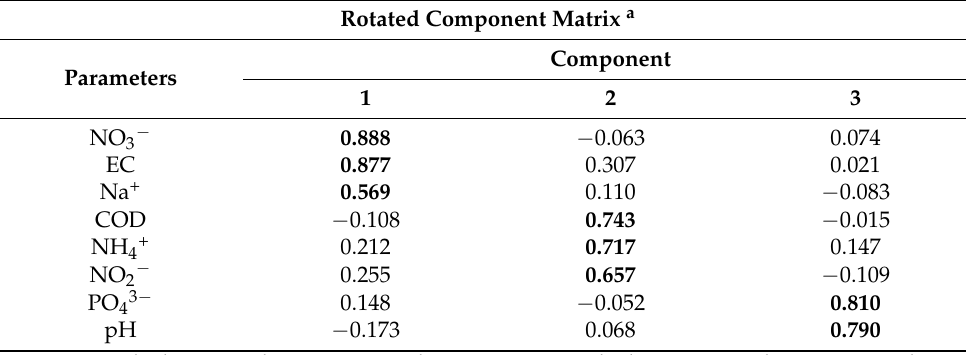
Table 4. Loadings of the variables on three significant principal components.